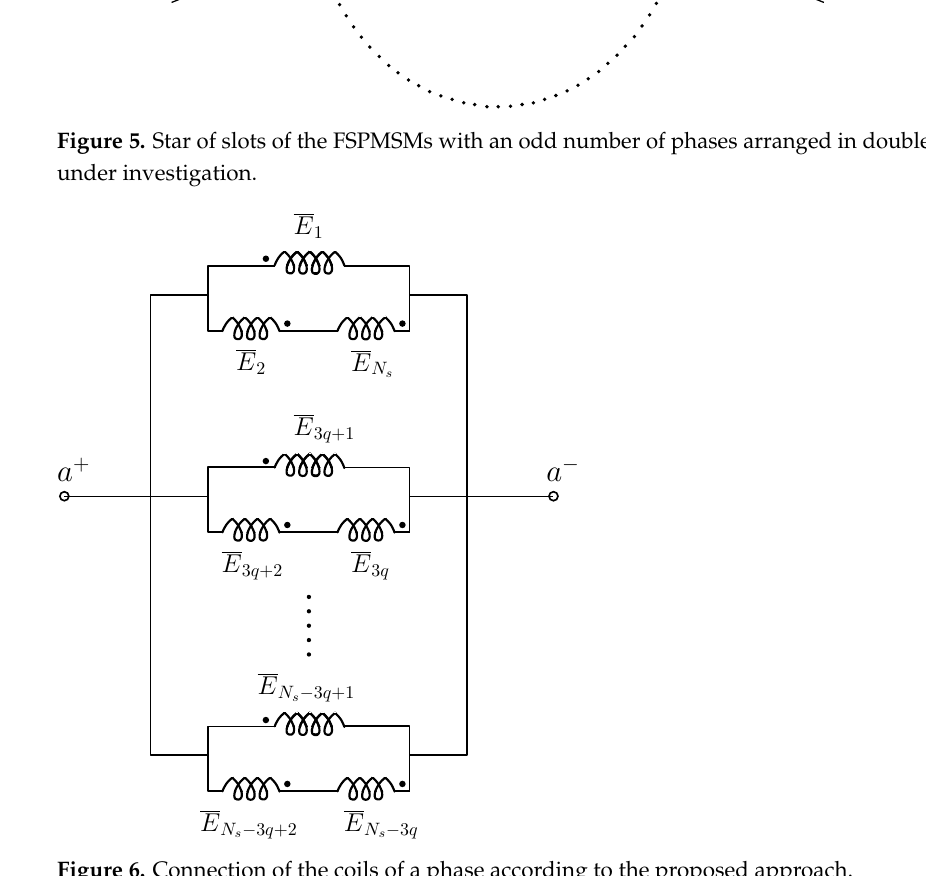
Figure 6. Connection of the coils of a phase according to the proposed